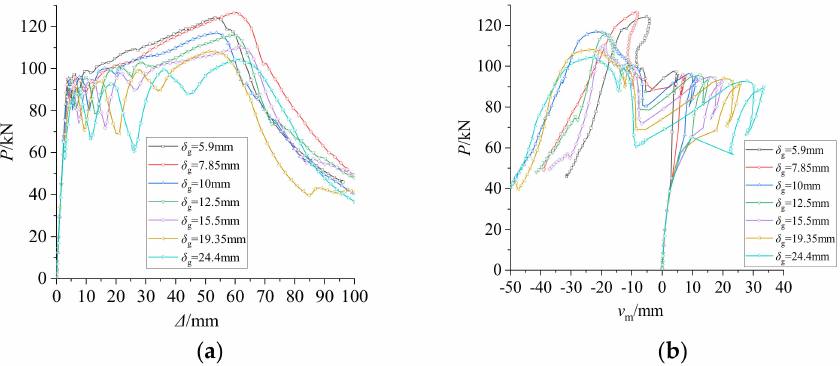
Figure 17. Effect of the gap between core tube and restraining tube: ( a ) P - ∆ relationships; ( b ) P - v m